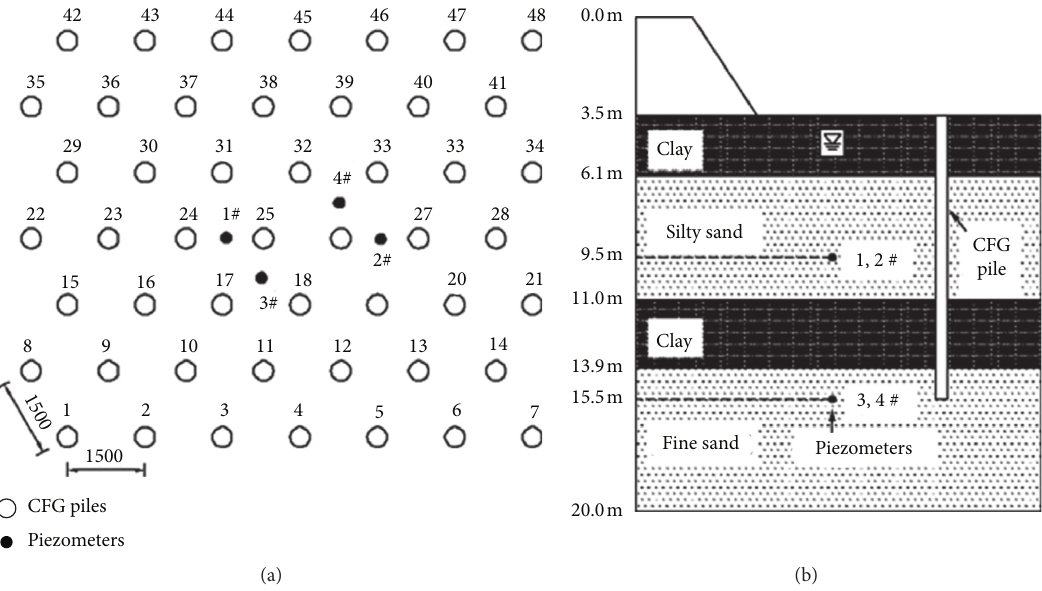
Figure 12: The layout plane of CFG piles and soil profiles of the test area. (a) Layout plane. (b) Soil profile.